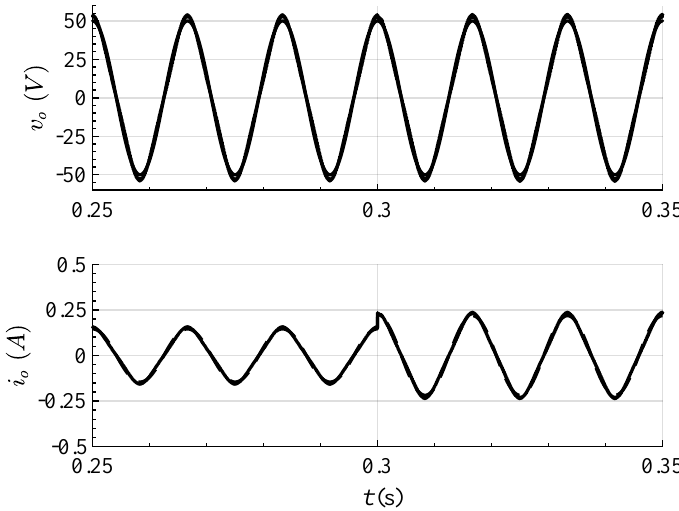
Figure 21. Output voltage and current due to an increase in the